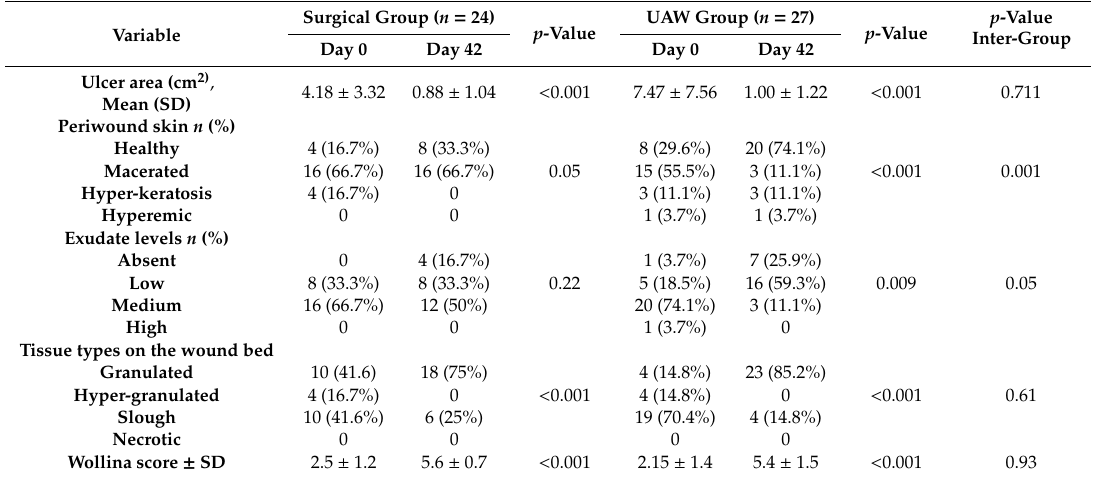
Table 2. Diabetic foot ulcers characteristics at week 0 (inclusion in the study, day 0) and at week six (day 42) in both groups of our study